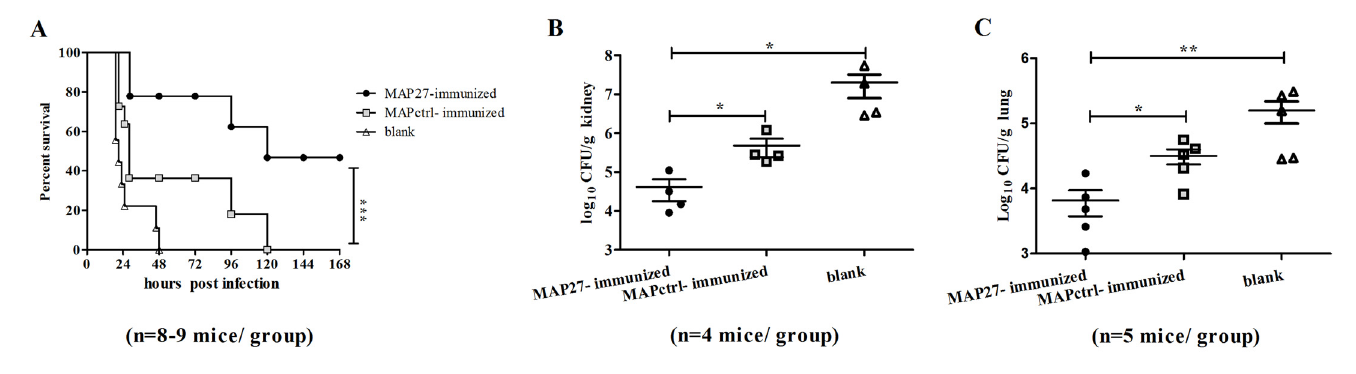
Fig 3. Immunization with MAP27 protects mice against S . aureus infection. (A) Survival analysis of mice with or without immunization after S . aureus infection. Five days after boosting with heat-inactivated S . aureus , all of BALB/c mice (including MAP27-immunized, MAPctrl-immunized and blank control, n = 8 – 9 mice/group) were challenged with S . aureus (ATCC 25923, 5×10 8 CFU/mouse) by intravenous injection. Survival rate were monitored for seven days after infection. (B) Bacterial numbers in kidney from three groups of mice (n = 4 mice per group) were measured after three days infection of S . aureus (2×10 7 CFU/mouse). (C) Bacterial numbers in lung from different groups of mice (n = 5 mice per group) were measured after three days infection. * P < 0.05, ** P < 0.01, *** P <